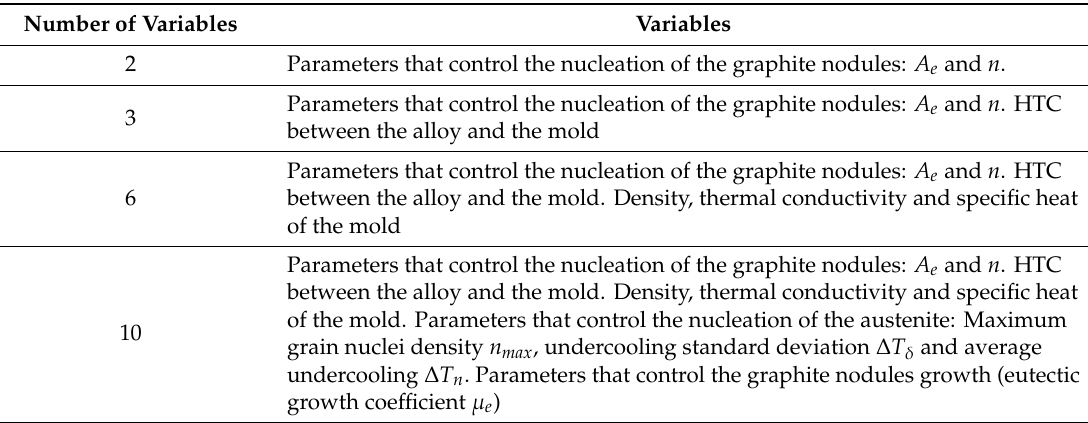
Table 2. Variables included in the model fitting